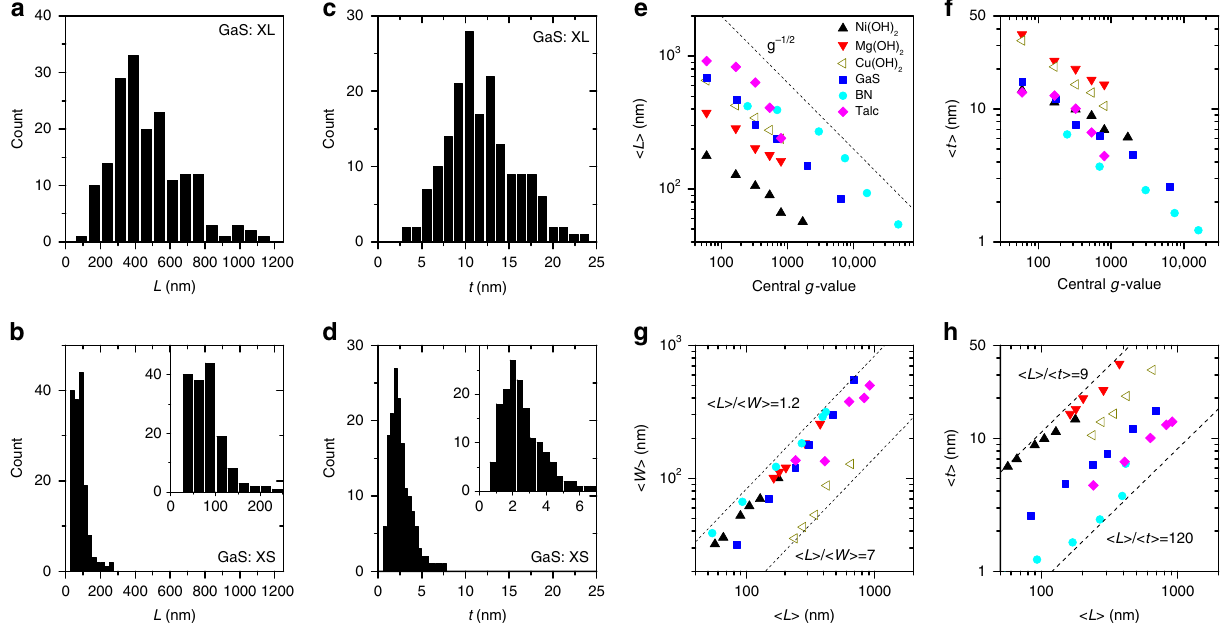
Fig. 3 Dimensions of size-selected nanosheets as extracted from AFM. a , b Histograms showing nanosheet length (the longest dimension) from the XL and XS fractions. c , d Histograms showing nanosheet thickness from the XL and XS fractions. The insets in b and d show magni fi ed versions of the XS data. e , f Mean nanosheet length ( e ) and thickness ( f ) plotted versus the central g -force used during size selection. The dashed line in e illustrates the expected scaling. The central g -force is the mean of the upper and lower g -force boundaries used to prepare each fraction. g , h Mean nanosheet width ( g ) and thickness ( h ), each plotted versus mean nanosheet length. The lines show extreme values of nanosheet length/width aspect ratios ( g ) and length/ thickness aspect ratios ( h ). In all cases the statistical data set from which histograms and means were calculated has a sample size of